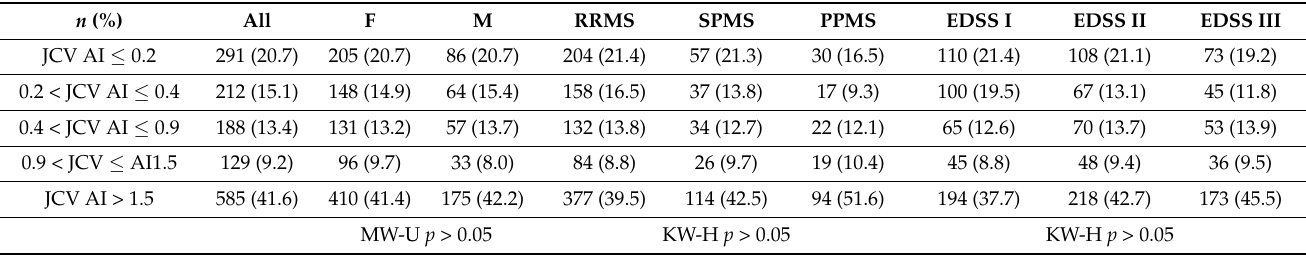
Table 5. Anti-JCV AI categories and sex, clinical course and EDSS score.